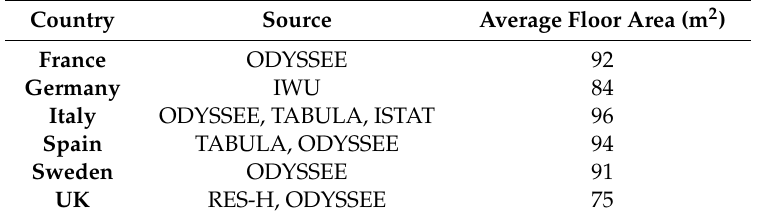
Table 4. Average size of dwellings (m 2 per dwelling).